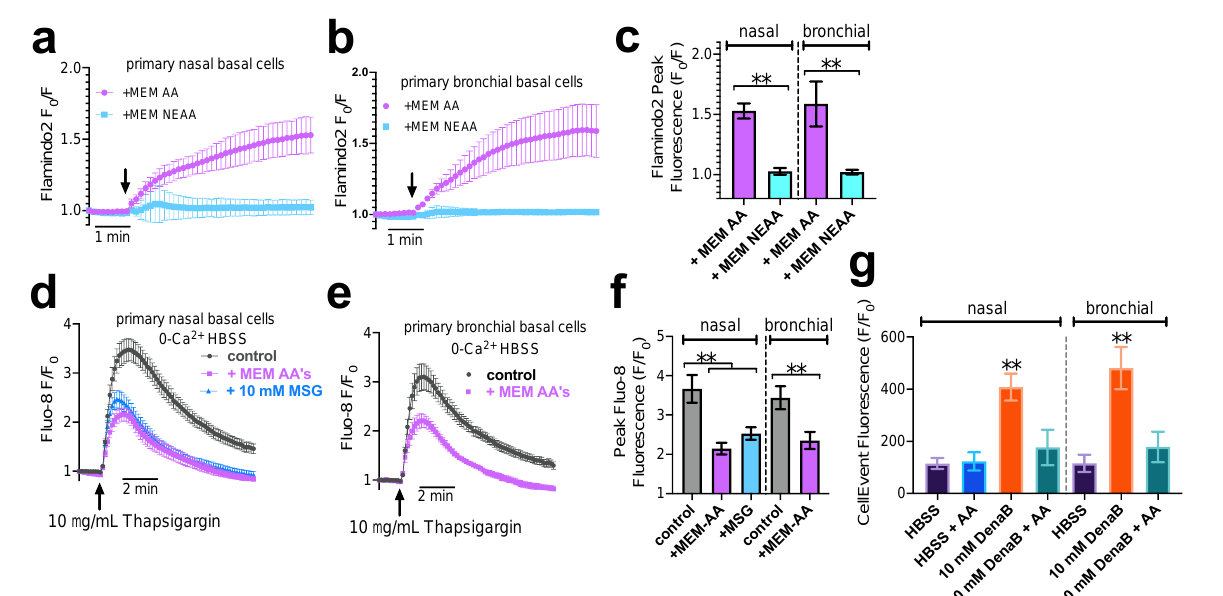
Figure 6. MEM AAs induce both cAMP increases and ER Ca 2+ store decreases as well as protect against bitter agonist-induced apoptosis in primary nasal and bronchial basal cells. ( a , b ) Representa- tive traces (n = 10 cells) showing increase in Flamindo2 F o /F (indicating cAMP increases) with MEM AA but not MEM NEAA in primary nasal ( a ) or bronchial ( b ) cells. Experiments were performed as in Figure 2 but with primary cells as indicated. (c) Bar graph of results from individual experiments as shown in ( a ) and ( b ). Data are from n = 3 experiments using cells from 3 different patients. ( d , e ) Representative traces of thapsigargin-induced Ca 2+ release as in Figure 3 but with primary nasal ( d ) or bronchial ( b ) basal cells after pre-treatment with MEM AAs or MSG as indicated. ( f ) Bar graph showing summary data from n = 4 experiments as in d and e using nasal cells from n = 4 individual patients and bronchial cells from n = 4 individual patients. ( g ) bronchial cells. ( g ) Bar graph showing CellEvent fluorescence after 6 h with primary nasal (left) or bronchial (right) cells in the presence of denatonium benzoate (DenaB) ± MEM AAs (AA) as indicated. All bar graphs were analyzed by one- way ANOVA with Bonferroni posttest and asterisks show significance compared with respective control; ** p < 0.01.